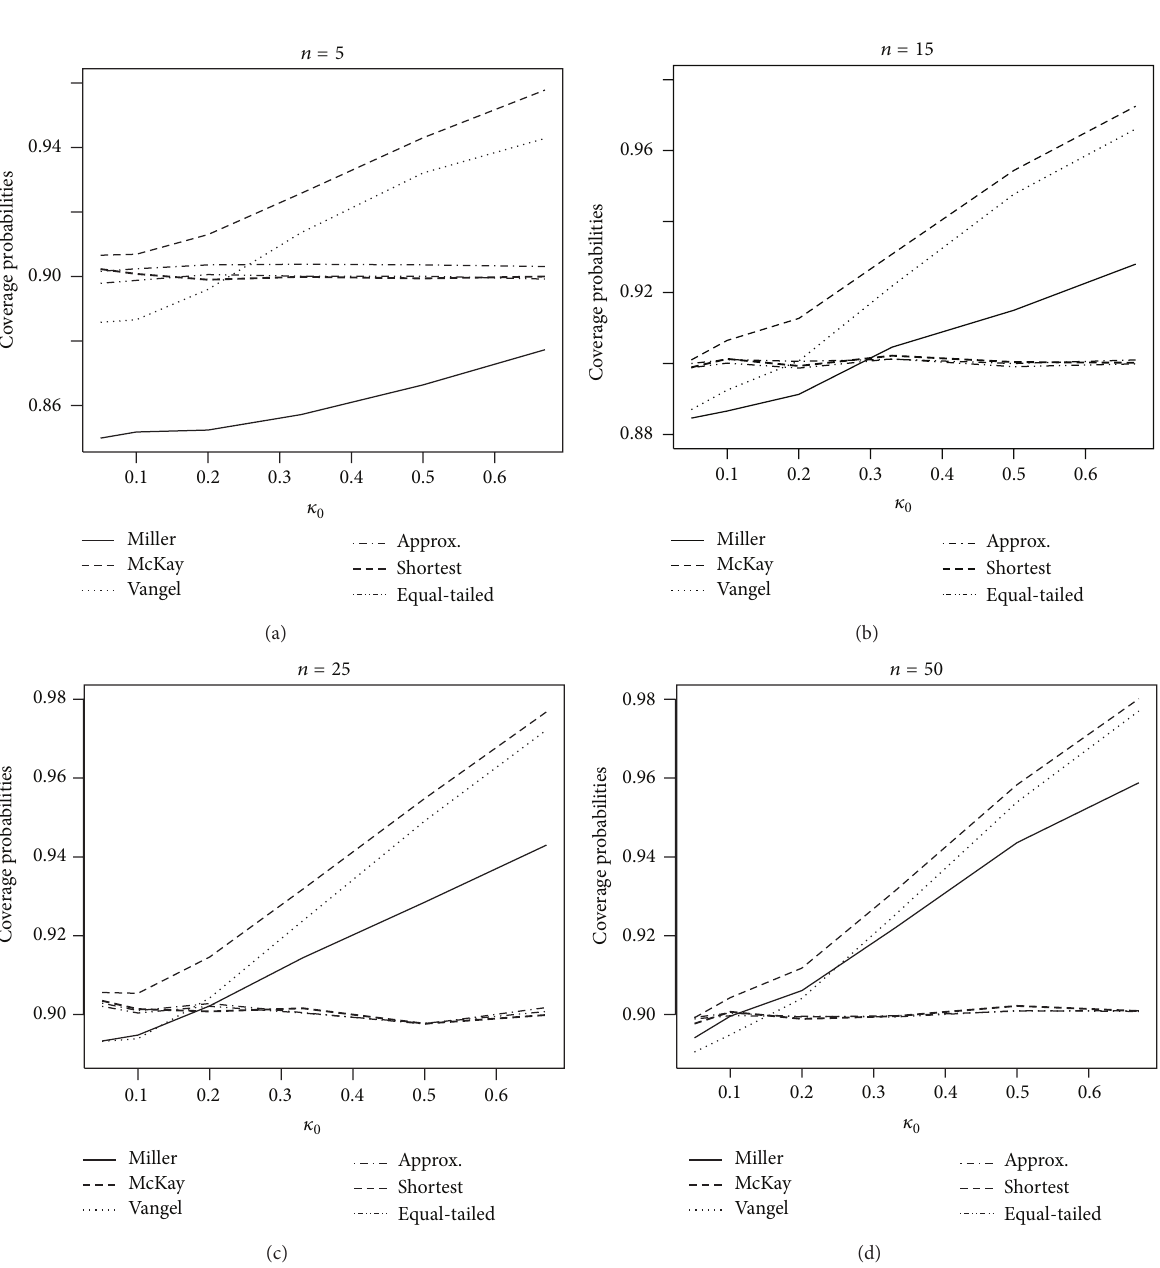
Figure 1: The estimated coverage probabilities of 90% confidence intervals for the coefficient of variation in a normal distribution with a known population